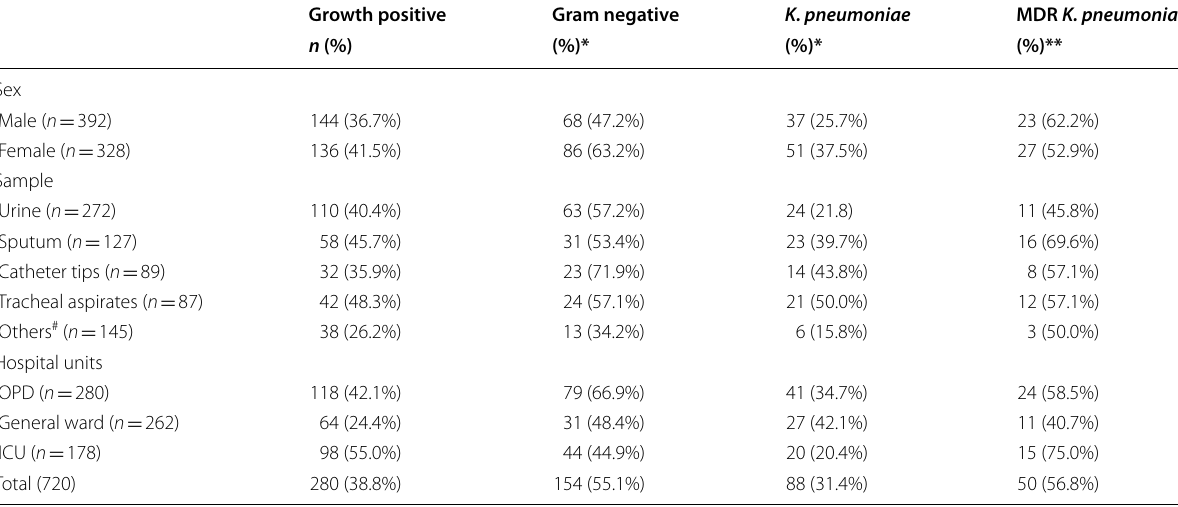
Table 1 Growth positivity according to sex, clinical samples, and hospital units